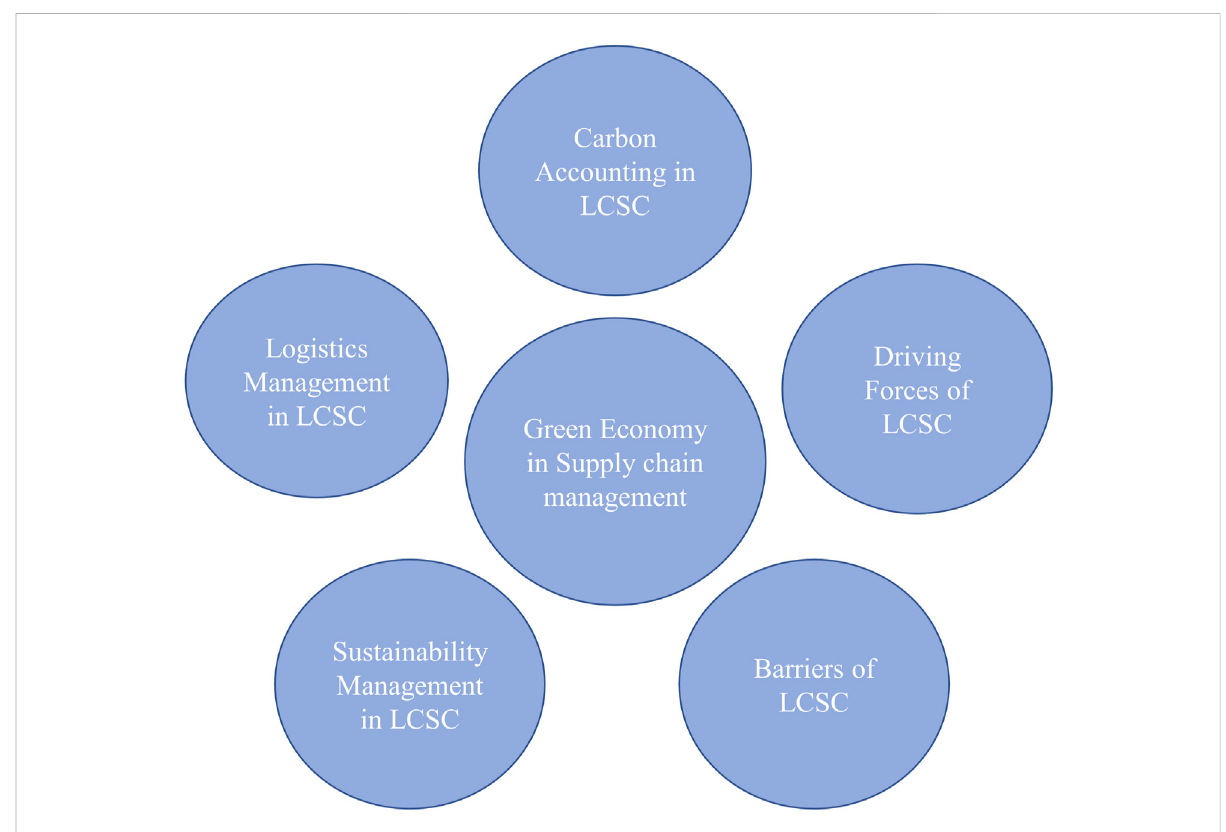
FIGURE 7 Green economy framework in the supply